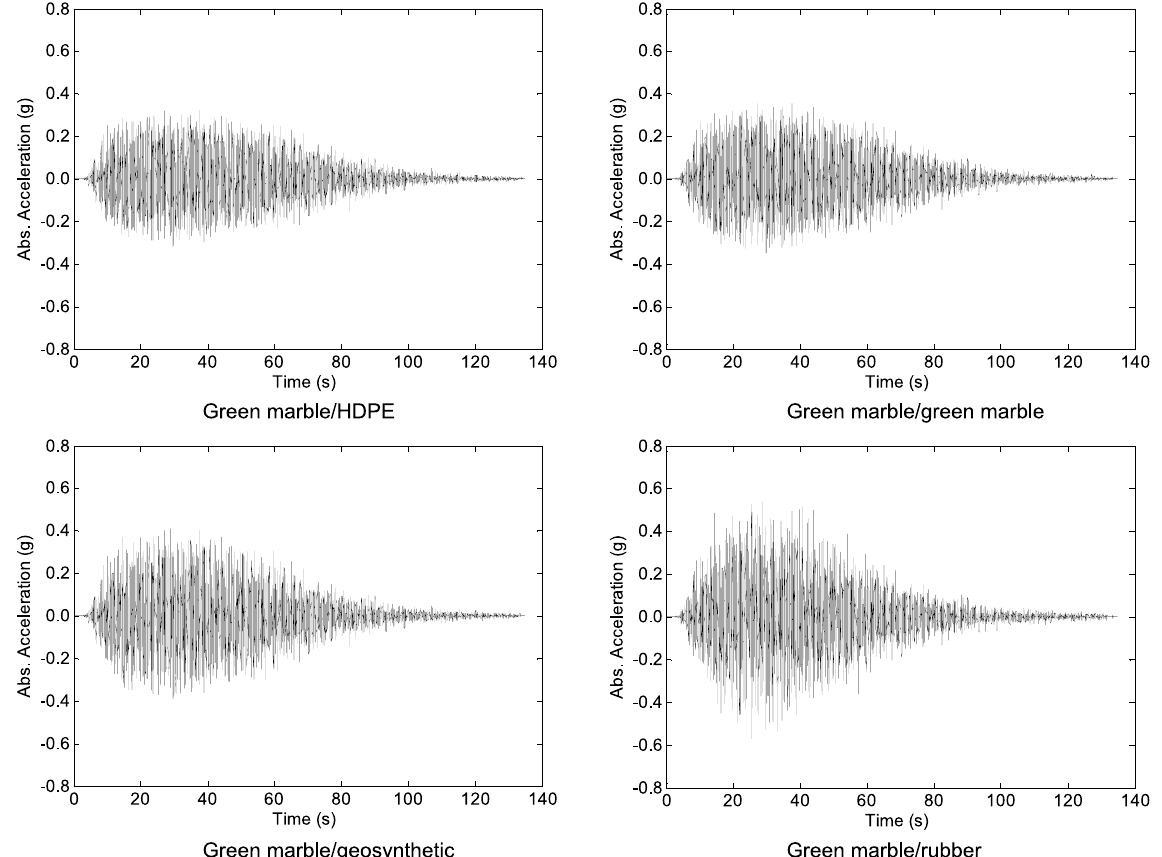
Fig. 7. Absolute acceleration response of roof mass for different sliding interfaces buildings.